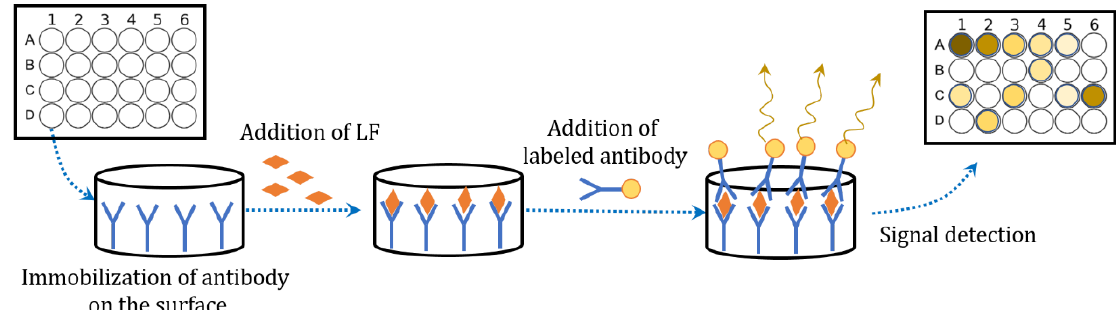
Figure 2. Scheme of sandwich ELISA method for lactoferrin detection.